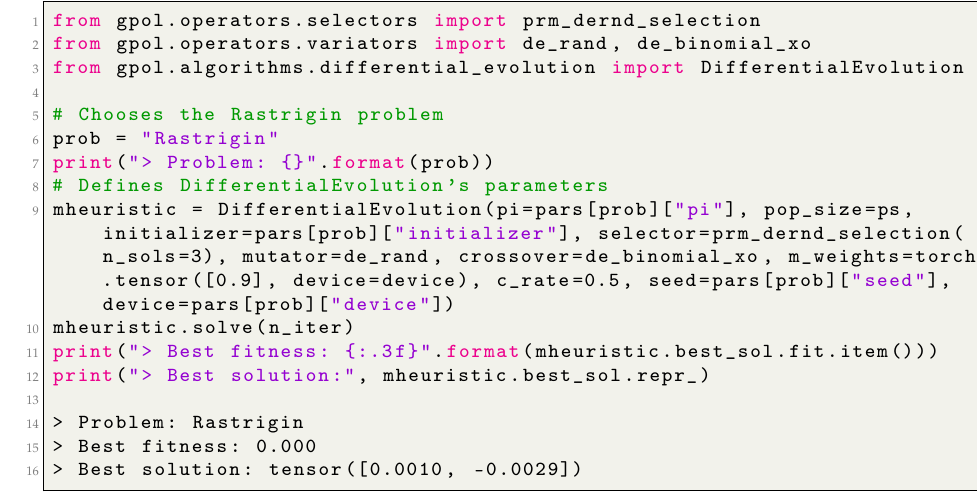
Figure A10. An example of DifferentialEvolution ’s application in continuous